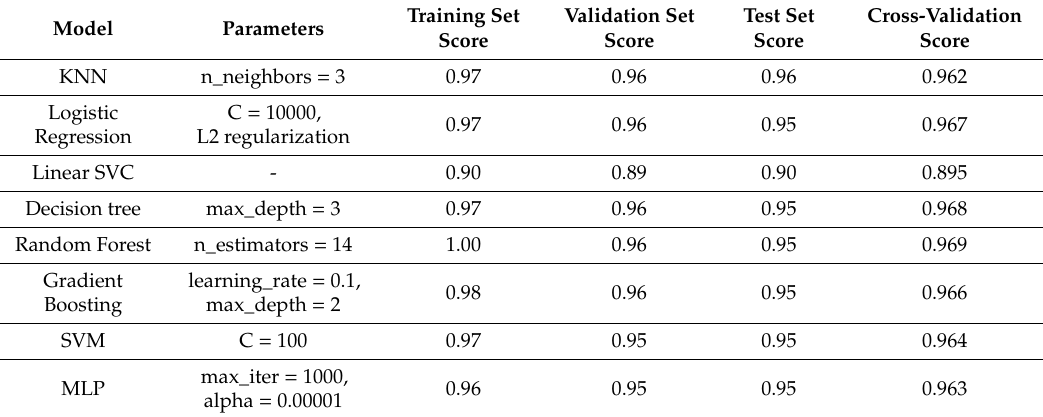
Table 5. Experiment results of training set, validation set, test set, and cross-validation using Dataset 1 with elapsed